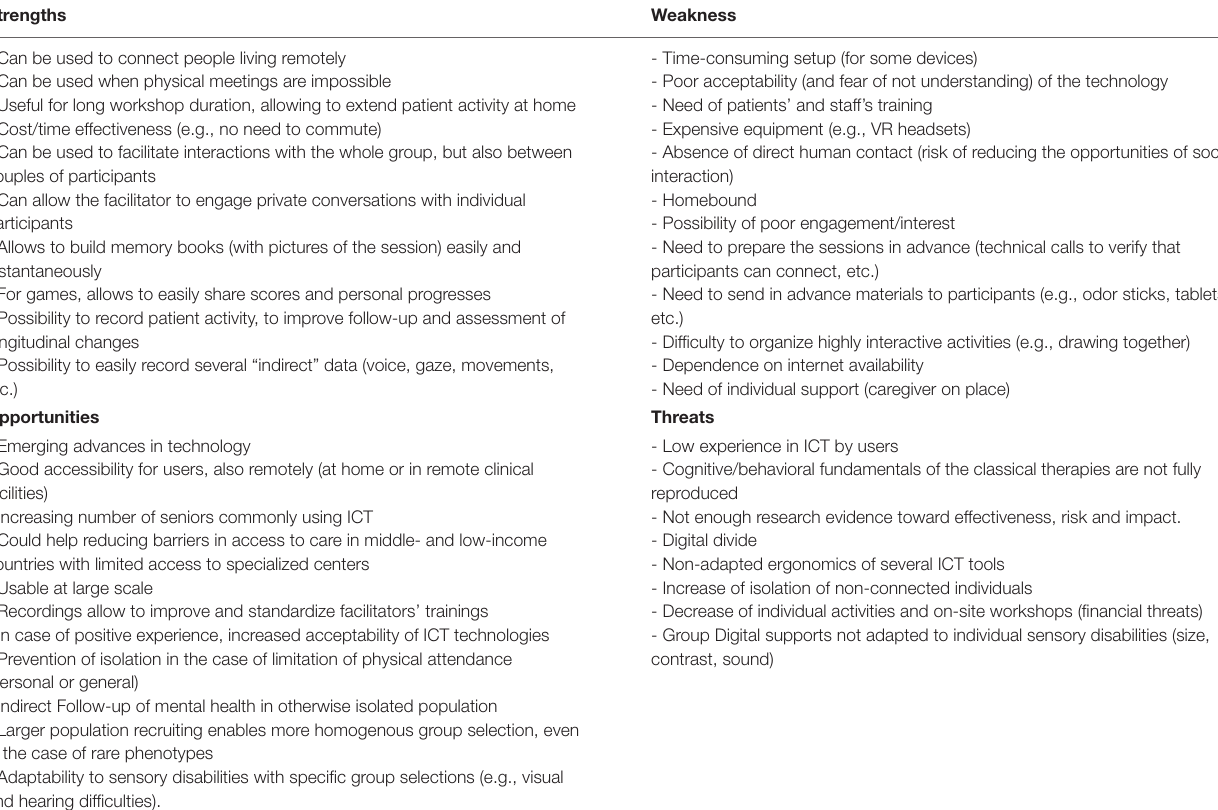
TABLE 5 | Summary of a Strengths, Weakness, Opportunities, and Threats (SWOT) Analysis of using ICT for workshop using art/board games. Strengths